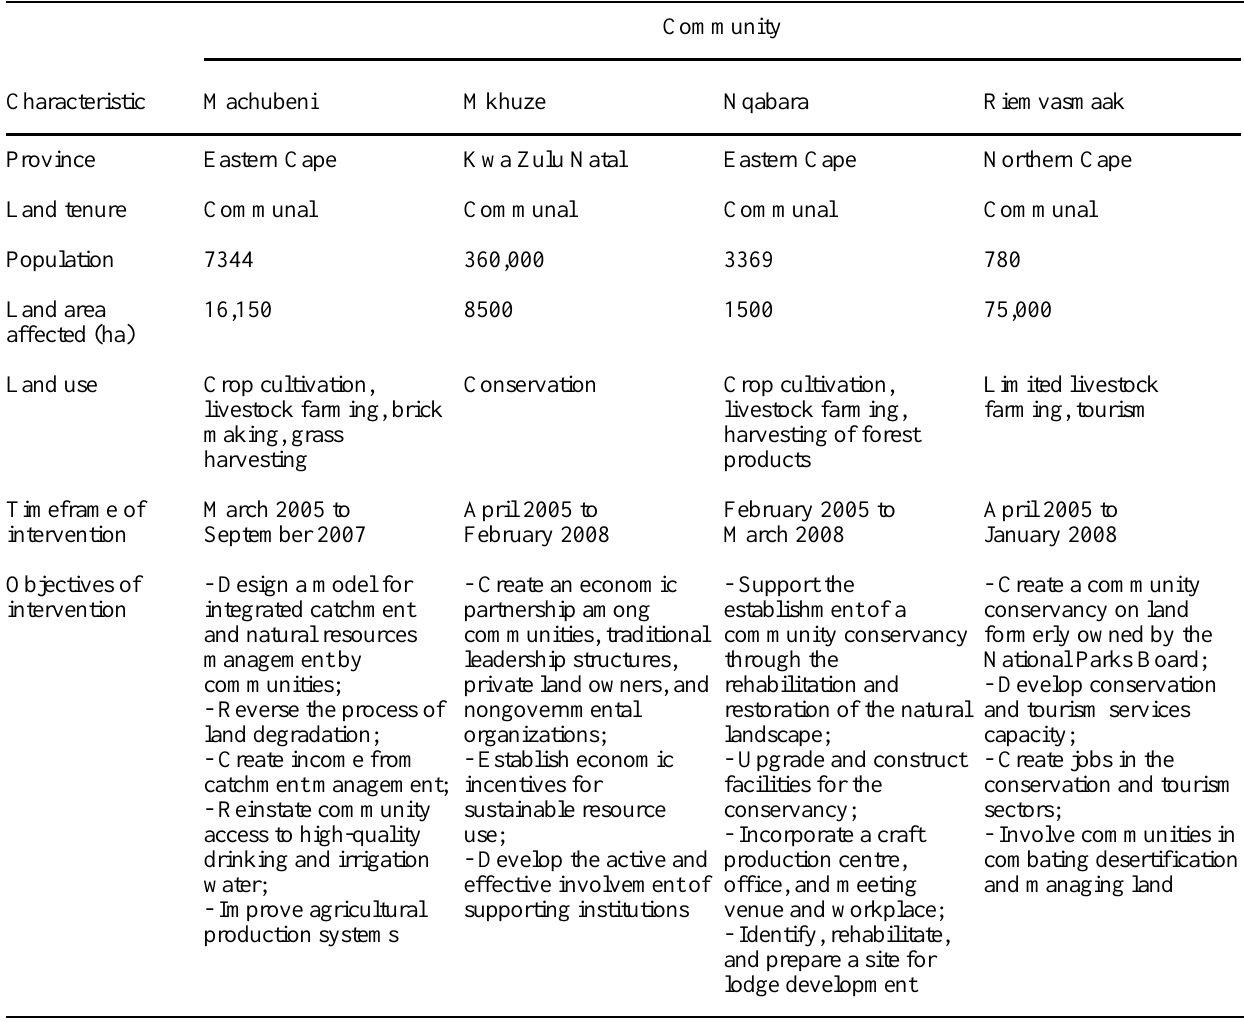
Table 1. Summary of the four case